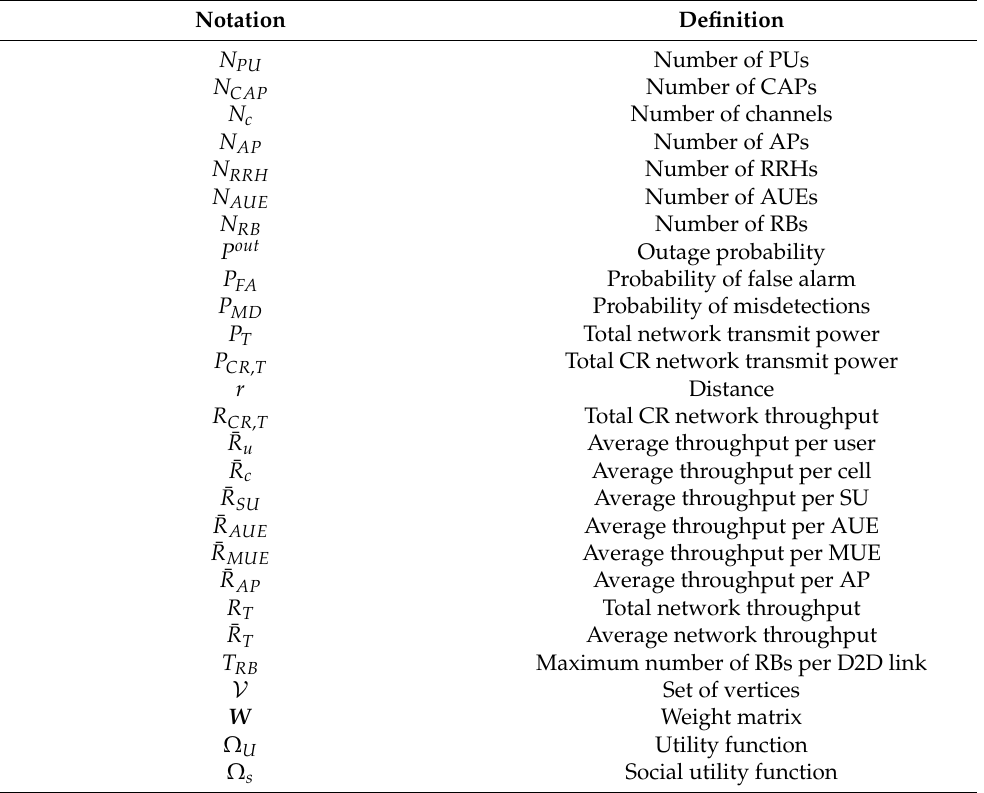
Table 4. Table of